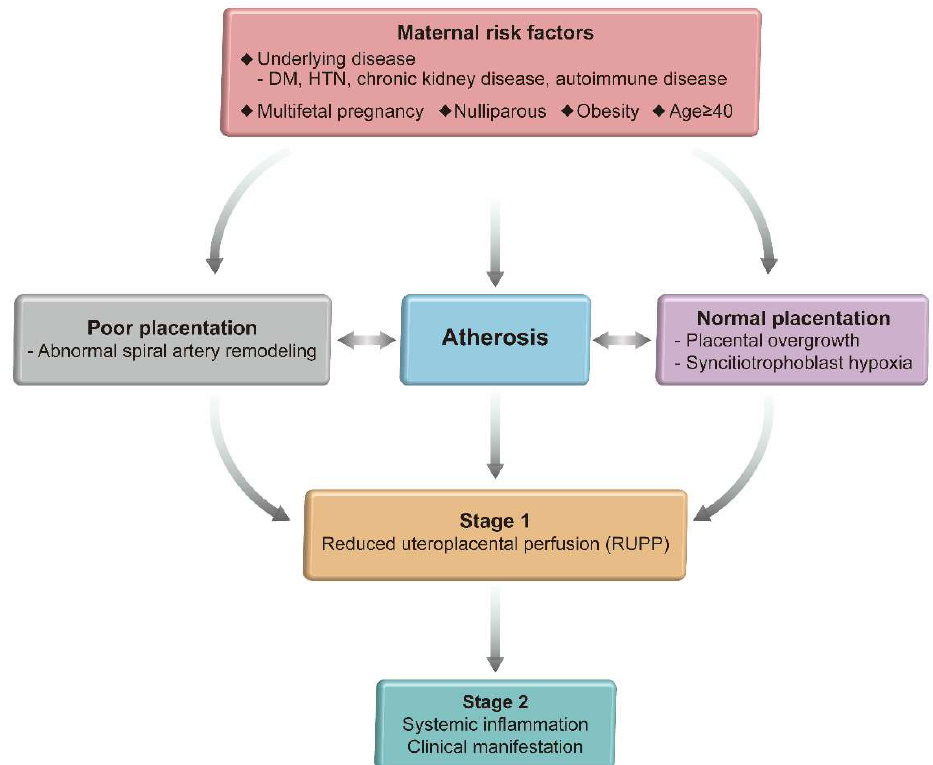
Figure 1. Two step model of preeclampsia.